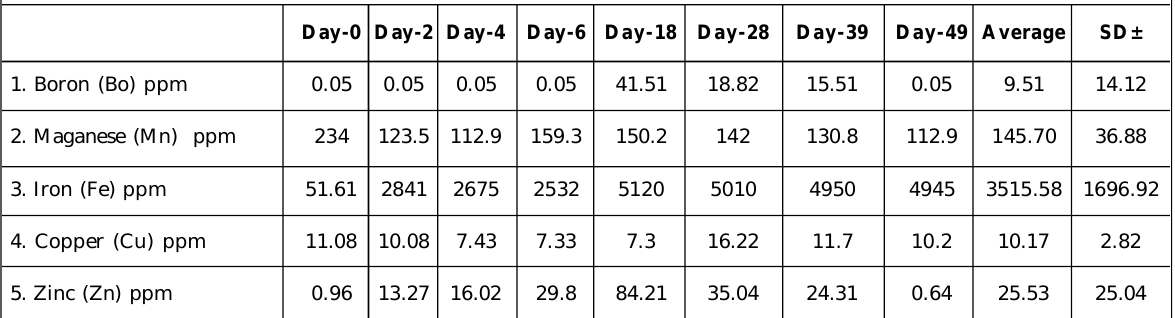
Table 4: Micronutrients variation trend during composting and WBM